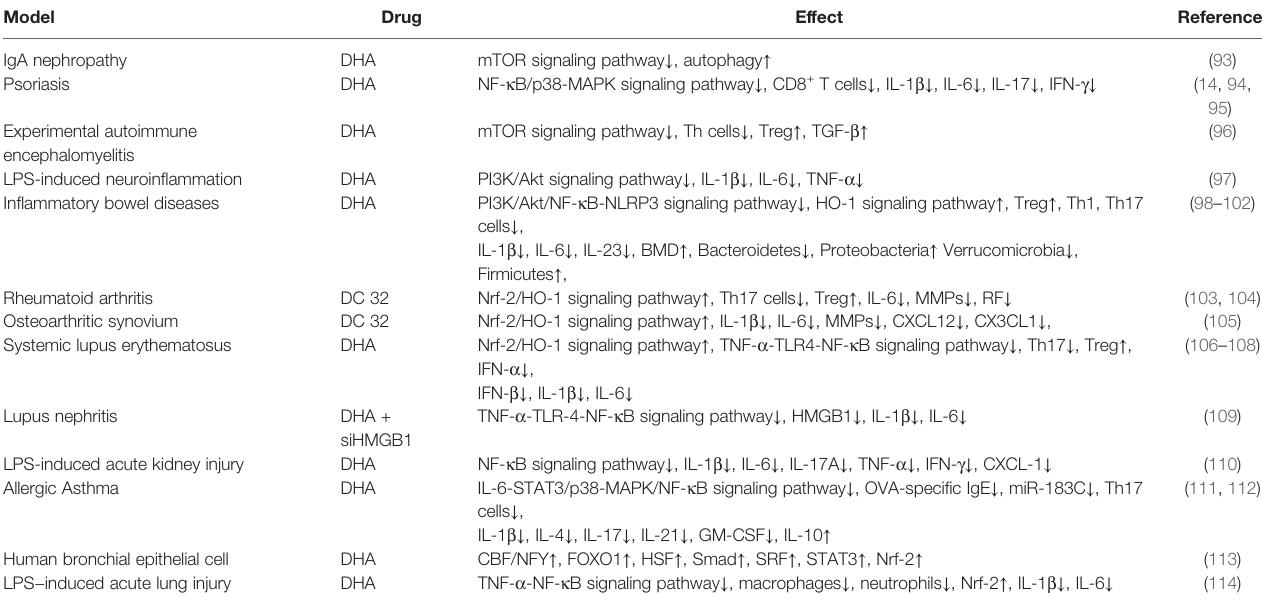
TABLE 2 | The effects of DHA in in fl ammatory diseases.